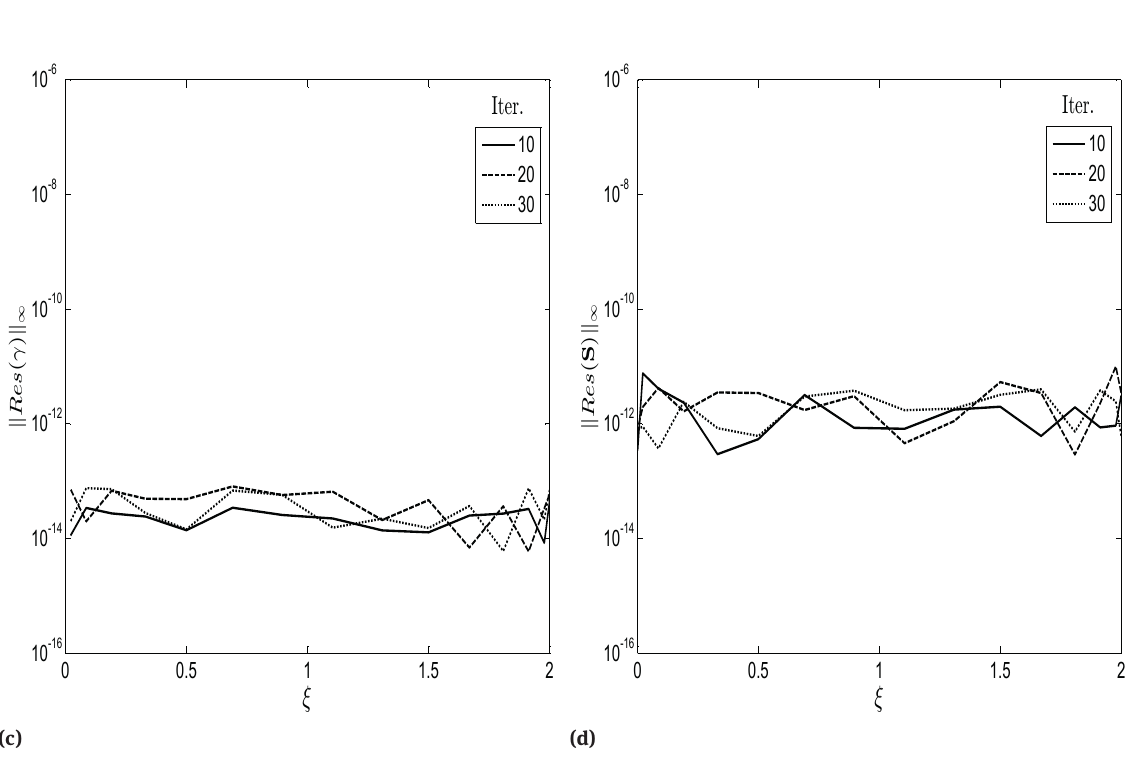
Fig. 2: Residual error over iterations when Pr = 1.0 , Sc = 0.6 , Gr = 1.0 , ε = 1.0 , Da = 0.5 , Fs = 1.0 , Bi = 1.0 , Ds = 0.2 , Dc = 0.3 , Nr = 0.5 , Nc = 1.0 , Le = 10 , Nb = 0.2 and Nt =